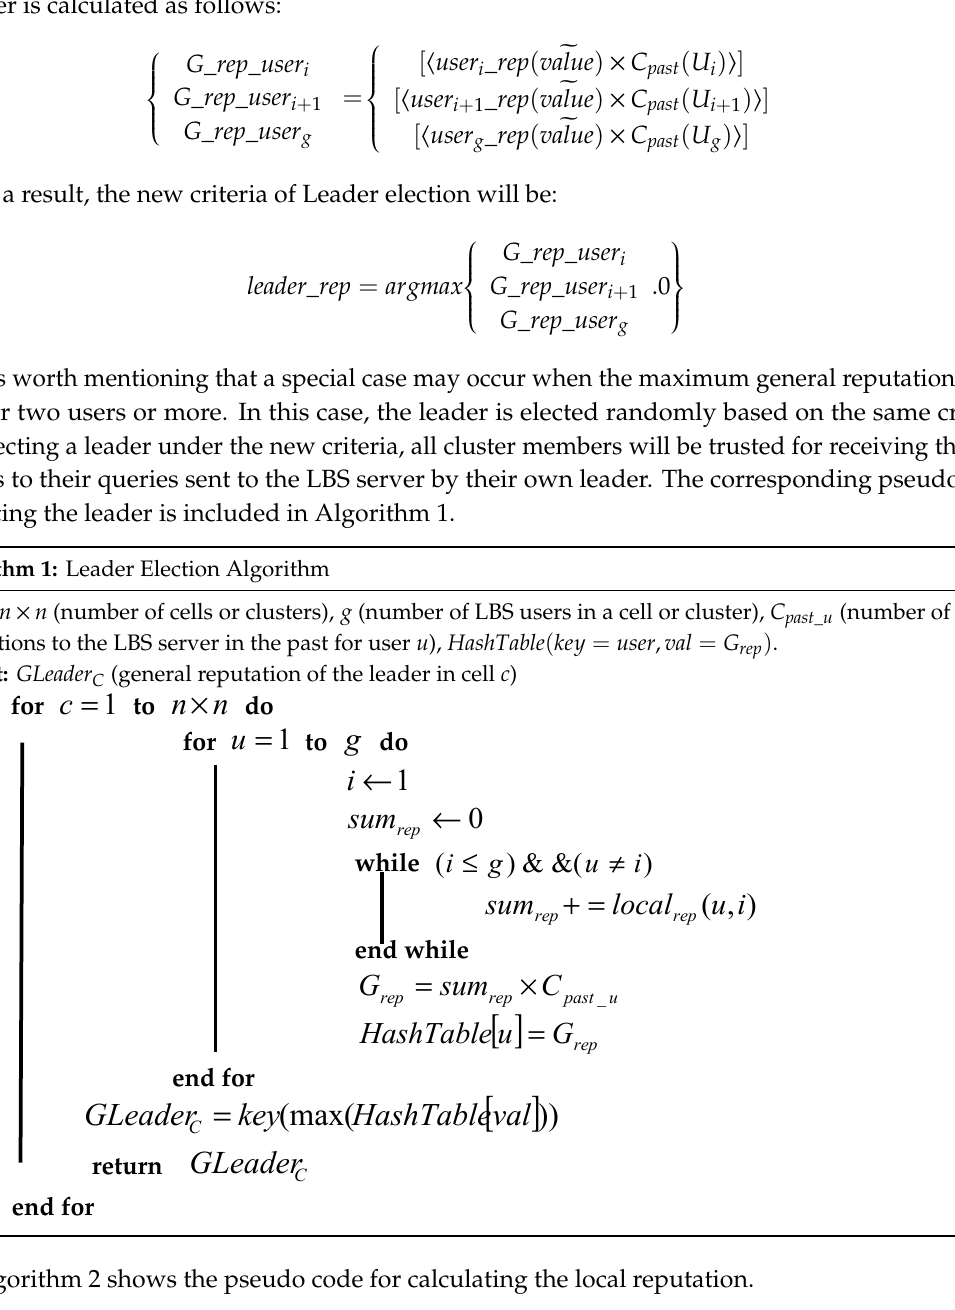
Algorithm 2: Calculating the Local Reputation ( local rep